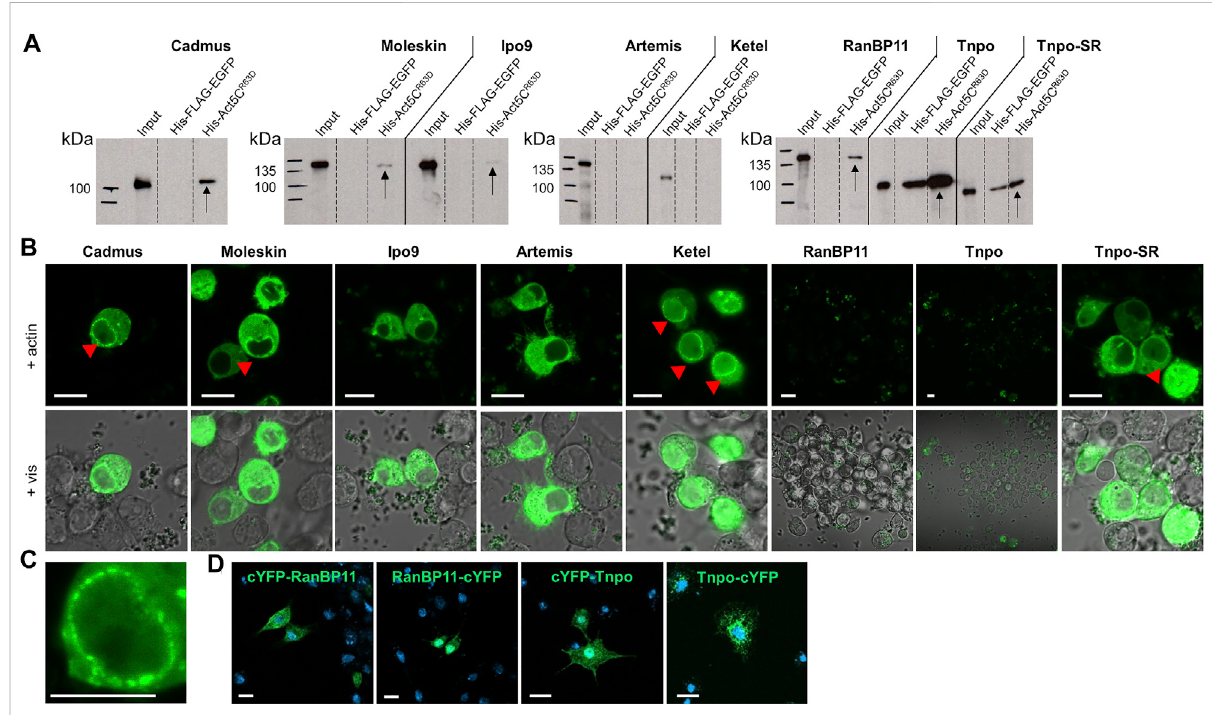
FIGURE 5 Multiple importins contribute to the robust nuclear localization of actin. (A) Pull-down experiment with importins and actin. Arrows mark the importins pulled down by actin. (B) Split-YFP screening for importins interacting (green) with actin in transfected live S2R + cells. Red arrowheads mark the punctate pattern of the fl uorescent signal at the nuclear envelope. Pictures show the results obtained with C-terminally tagged importins. Vis — visiblelight.Scalebar,50 μ m. (C) Magni fi cationshowingthepunctatepatternatthenuclearmembrane.Scalebar,50 μ m. (D) Visualization of protein expression. Transfected S2R + cells were immunostained with anti-HA antibody (green) for N-terminally (cYFP-RanBP11 and cYFP-Tnpo) and C-terminally (RanBP11-cYFP and Tnpo-cYFP) tagged RanB11 and Tnpo proteins. DAPI staining, blue. Scale bar, 100 μ